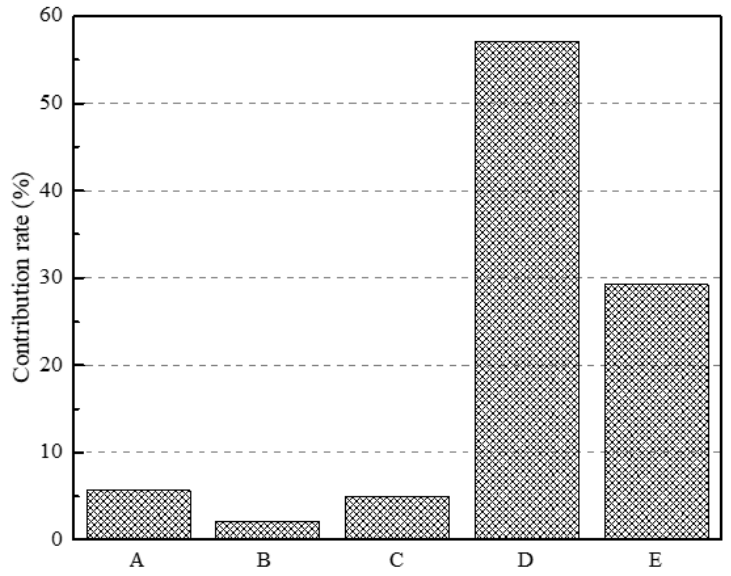
Figure 16. Contributions of each factor to the pressure drop.